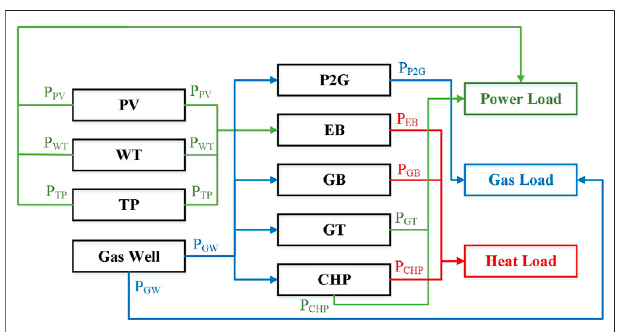
FIGURE 1 | Structure of the